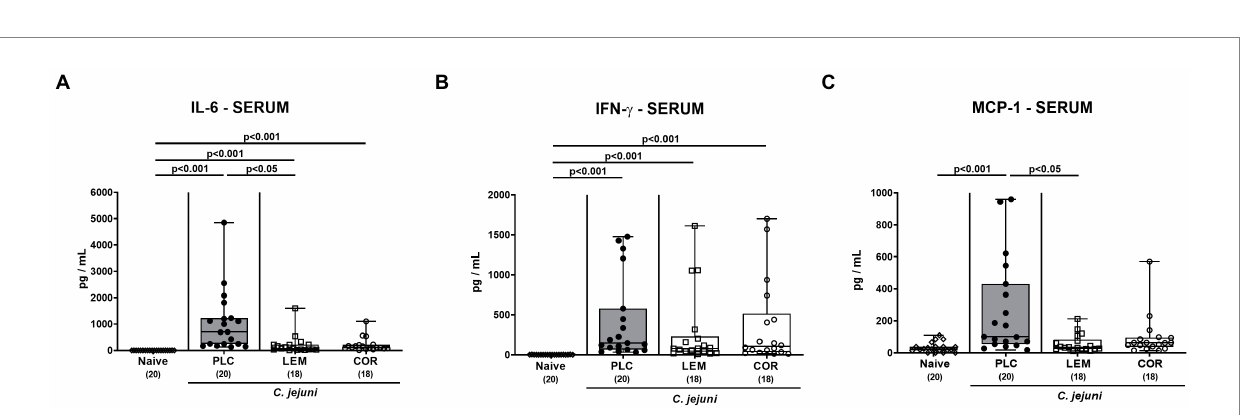
FIGURE 7 Systemic pro-inflammatory mediator secretion following prophylactic oral application of lemon or coriander essential oil to C. jejuni infected mice. SAB IL-10 − / − mice were subjected to prophylactic lemon (LEM; white squares) or coriander (COR; white circles) essential oil via the drinking water ( ad libitum ) starting 7 days prior infection. Placebo (PLC; black circles) control animals received tap water only. On days 0 and 1, mice were then perorally infected with C. jejuni strain 81–176 by gavage. On day 6 post-infection, (A) IL-6, (B) IFN- γ and (C) MCP-1 concentrations were measured in serum samples. Naive mice were included as non-infected, untreated controls (white diamonds). Box plots (indicating the 25th and 75th percentiles), whiskers (indicating the minimum and maximum values), medians (black bar inside box) and numbers of analyzed mice (in parentheses) are shown. Significance levels ( p values) were calculated by the Kruskal-Wallis test with Dunn’s post-correction using pooled data from four independent